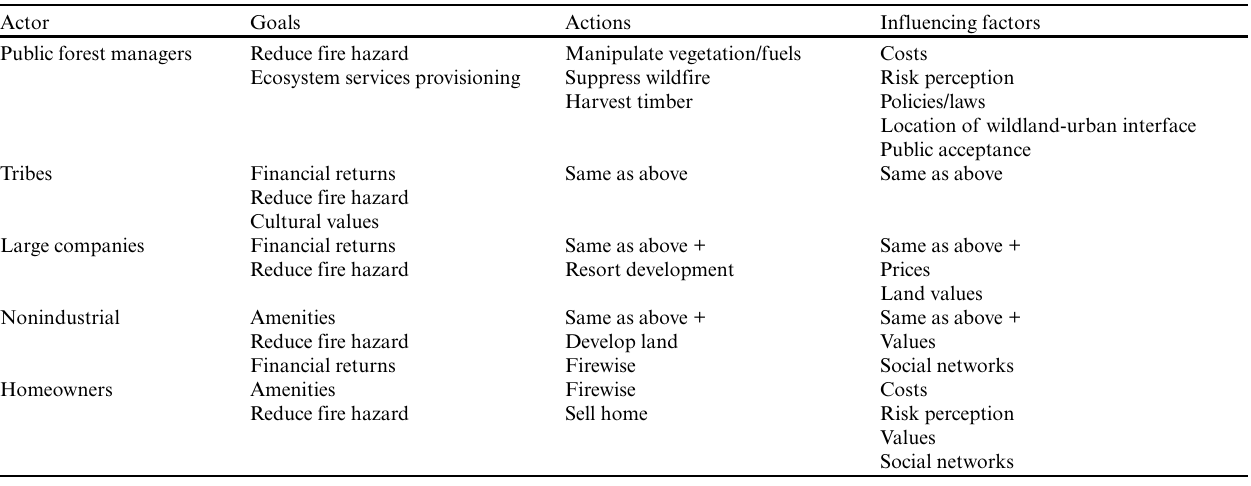
Table 1. Major forest actor groups, ownership goals, actions, and potential factors that might influence their decision-making in central and south-central Oregon, USA. Information is based on published material (e.g., Fischer 2011, Fischer et al. 2014) and interviews with land owners.